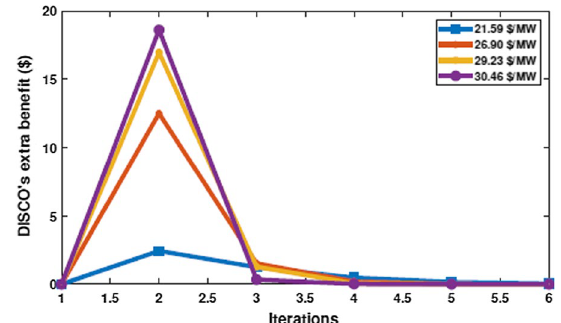
Fig. 8 Variation of DISCO’s extra benefit at different market